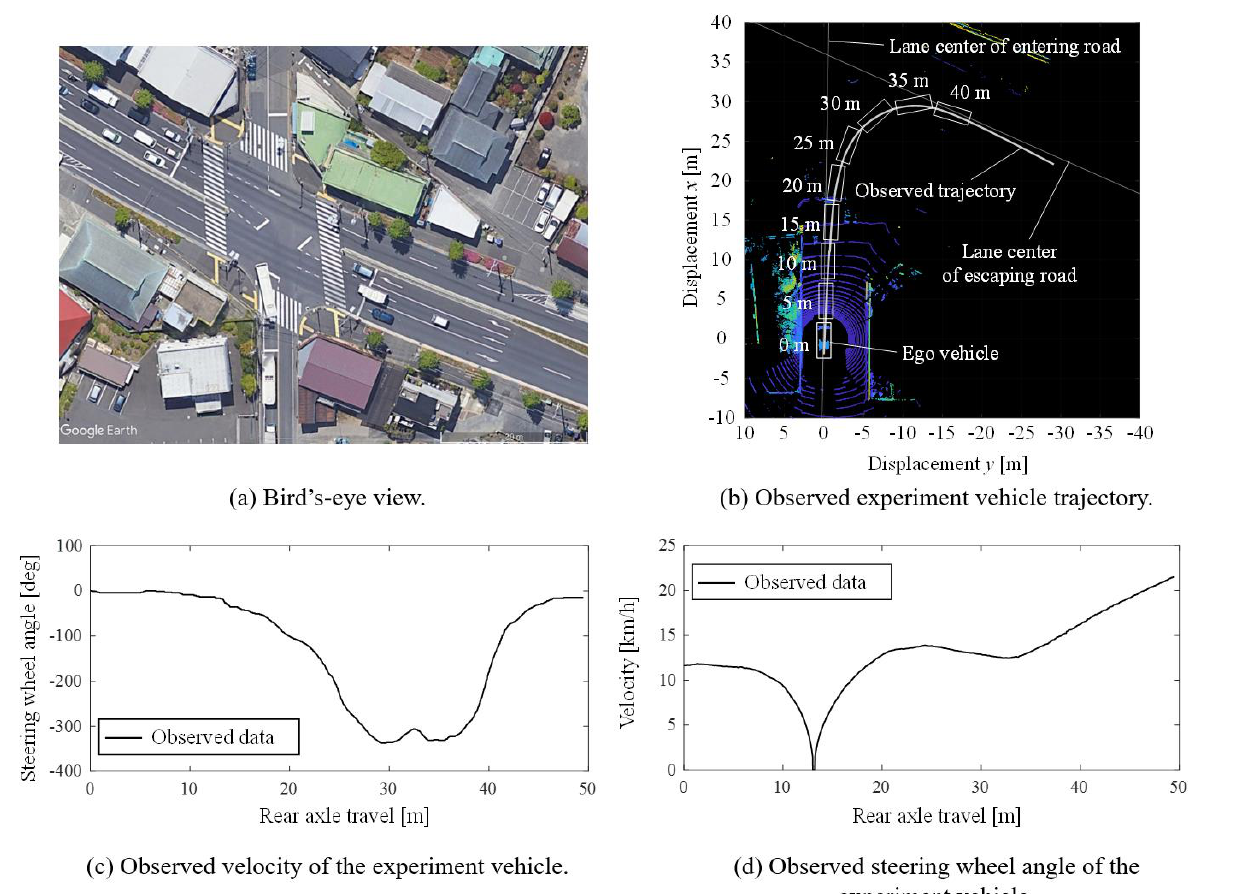
Figure 5. The target intersection and recorded data of an example case from the intersection right turning experiments. ( a ) Bird’s-eye view; ( b ) Observed experiment vehicle trajectory; ( c ) Observed velocity of the experiment vehicle; ( d ) Observed steering wheel angle of the experiment